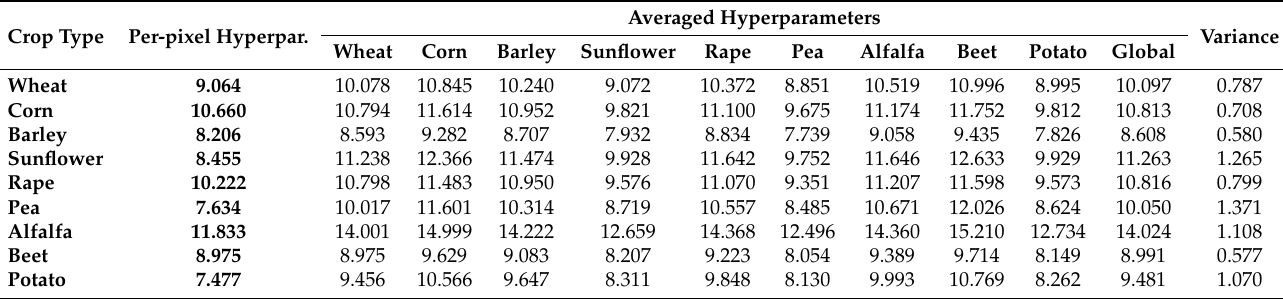
Table 4. Variation in percentage of LAI G obtained with precalculated hyperparameters with respect to the original LAI time series (lowest values in bold). Last column exhibits the variance in the percentage. Crop Type Per-pixel Hyperpar.